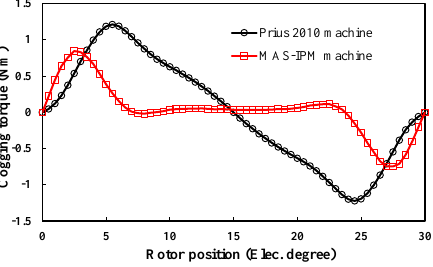
Figure 8. Cogging torque waveforms.